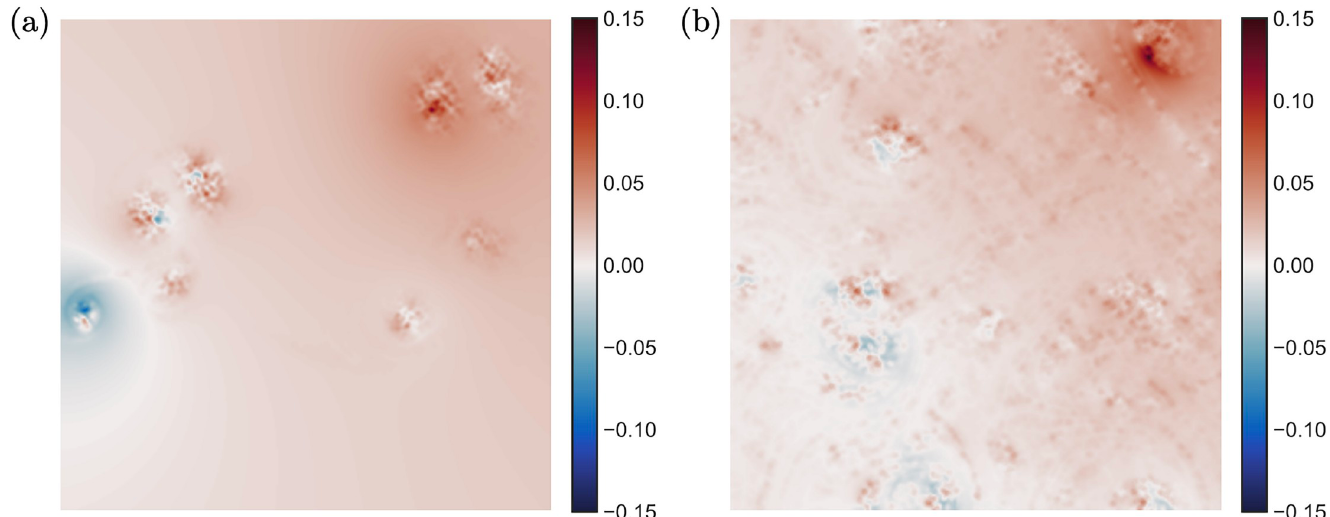
Fig 7. Relative approximation error between the deterministic and approximate dominant eigenvector as in Fig 6, distributed in the spatial domain: (a) airfoil wake flow, (b) two-dimensional isotropic turbulent flow.